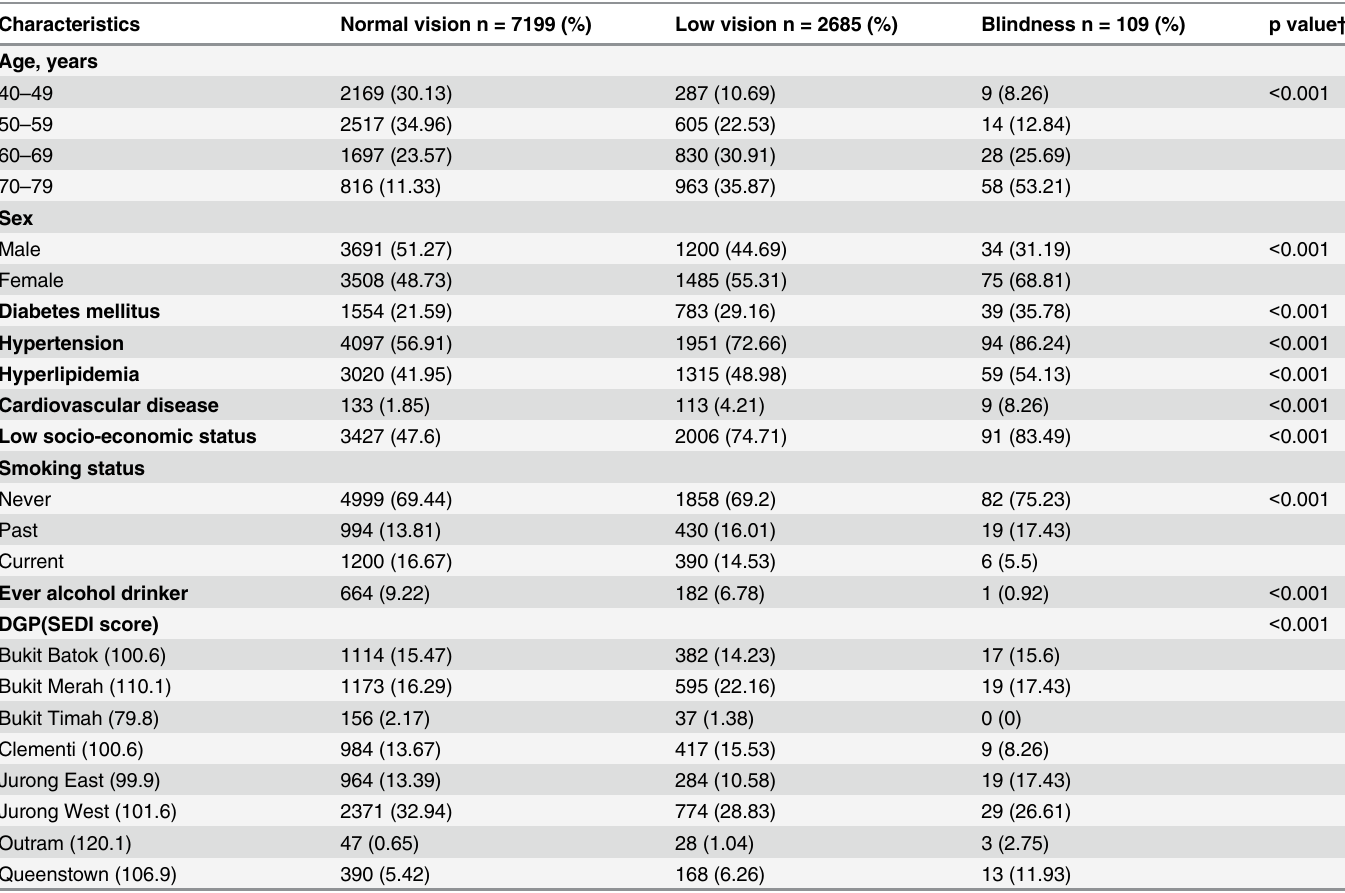
Table 1. Characteristics of participants in the Singapore Epidemiology of Eye Diseases study stratified by the severity of visual impairment.